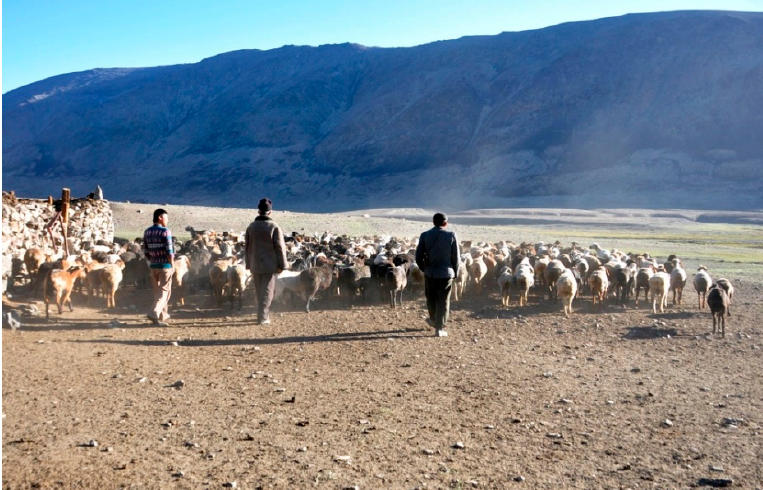
Figure 9. A flock of sheep/goats marching from one of the jailoo in the Karakul area to Sary-Mogol for illicit sale (Photograph: T.W., August 2010).